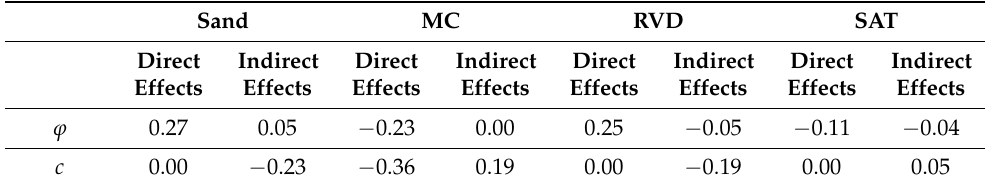
Table 2. Standardized direct and indirect effects of internal frictional